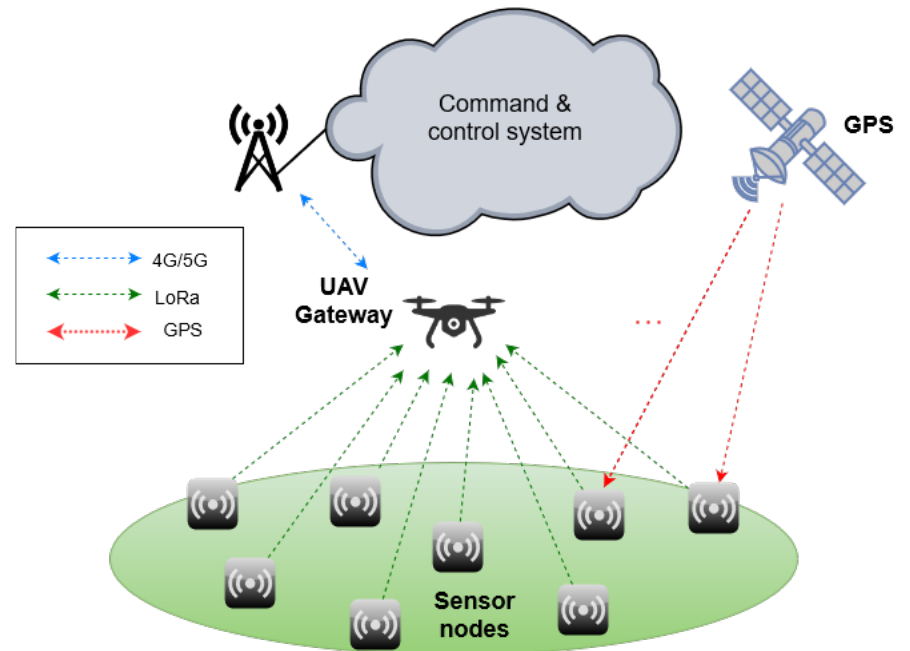
Figure 1. SensorQ system architecture.